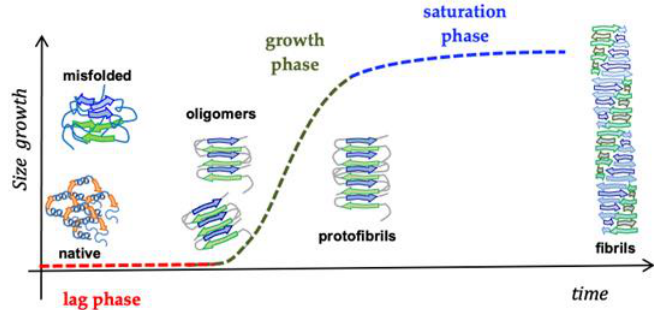
Figure 2. Scheme of the amyloid aggregation phases.